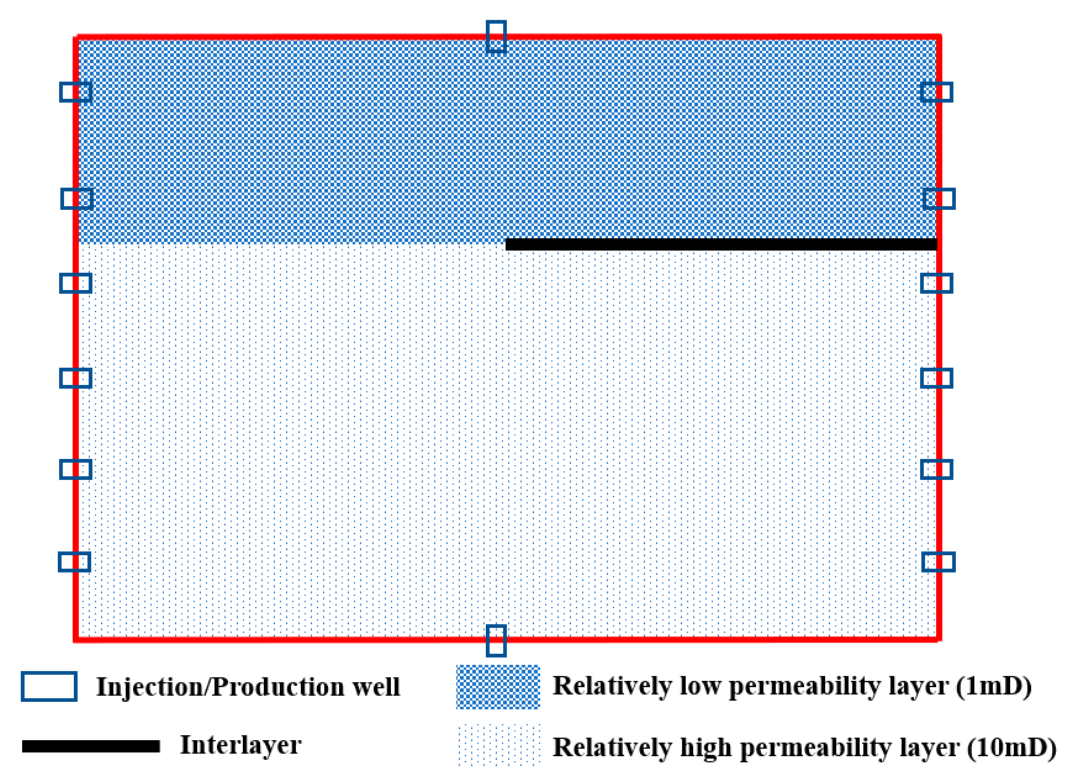
Figure 1. Design diagram of the 2D double-layer heterogeneous visualization model.